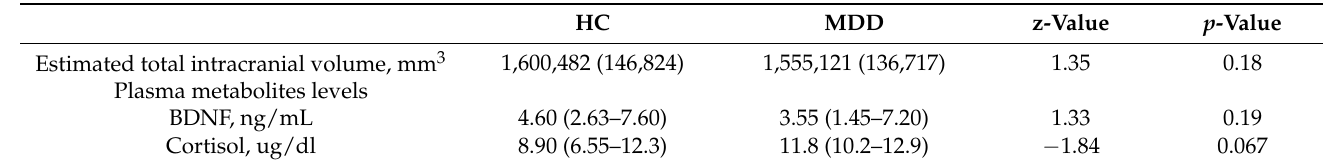
Table 2. Estimated total intracranial volume and plasma levels of metabolites.